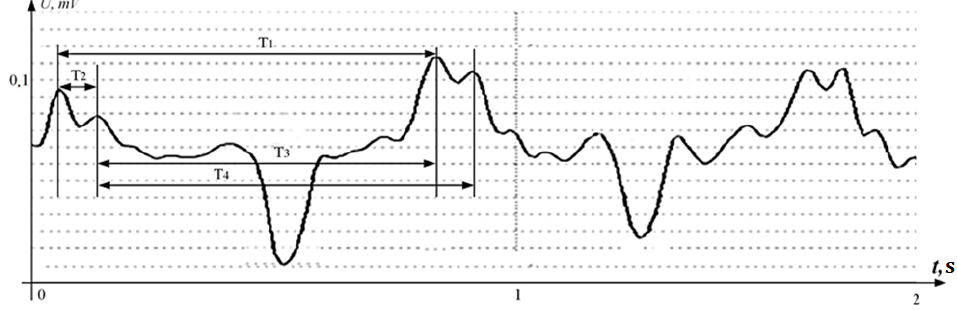
Figure 4. Ultrasonic signal reflected from the fetal heart after full-wave rectification.